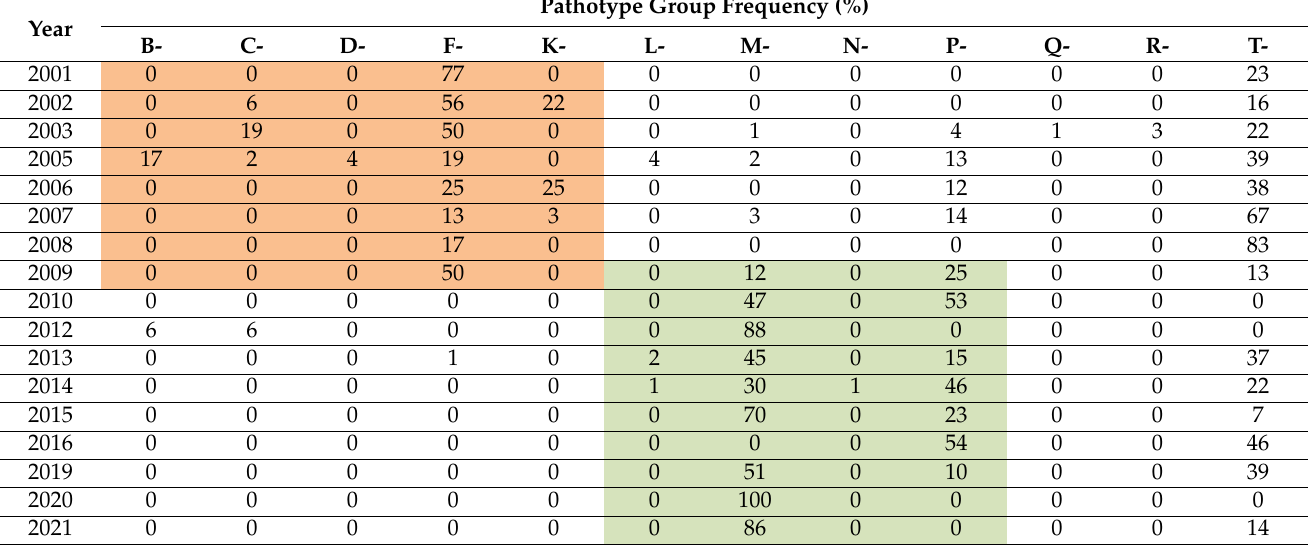
Table 3. Frequencies of pathotype groups of Puccinia triticina in North-Western Region of Russia in 2001–2021.